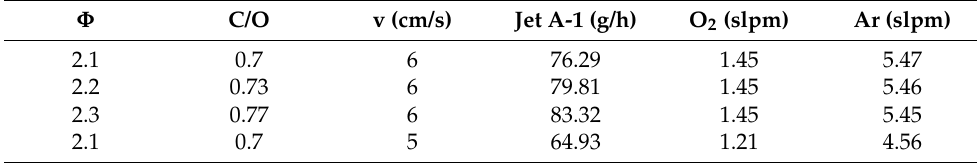
Table 1. Overview of the investigated operating